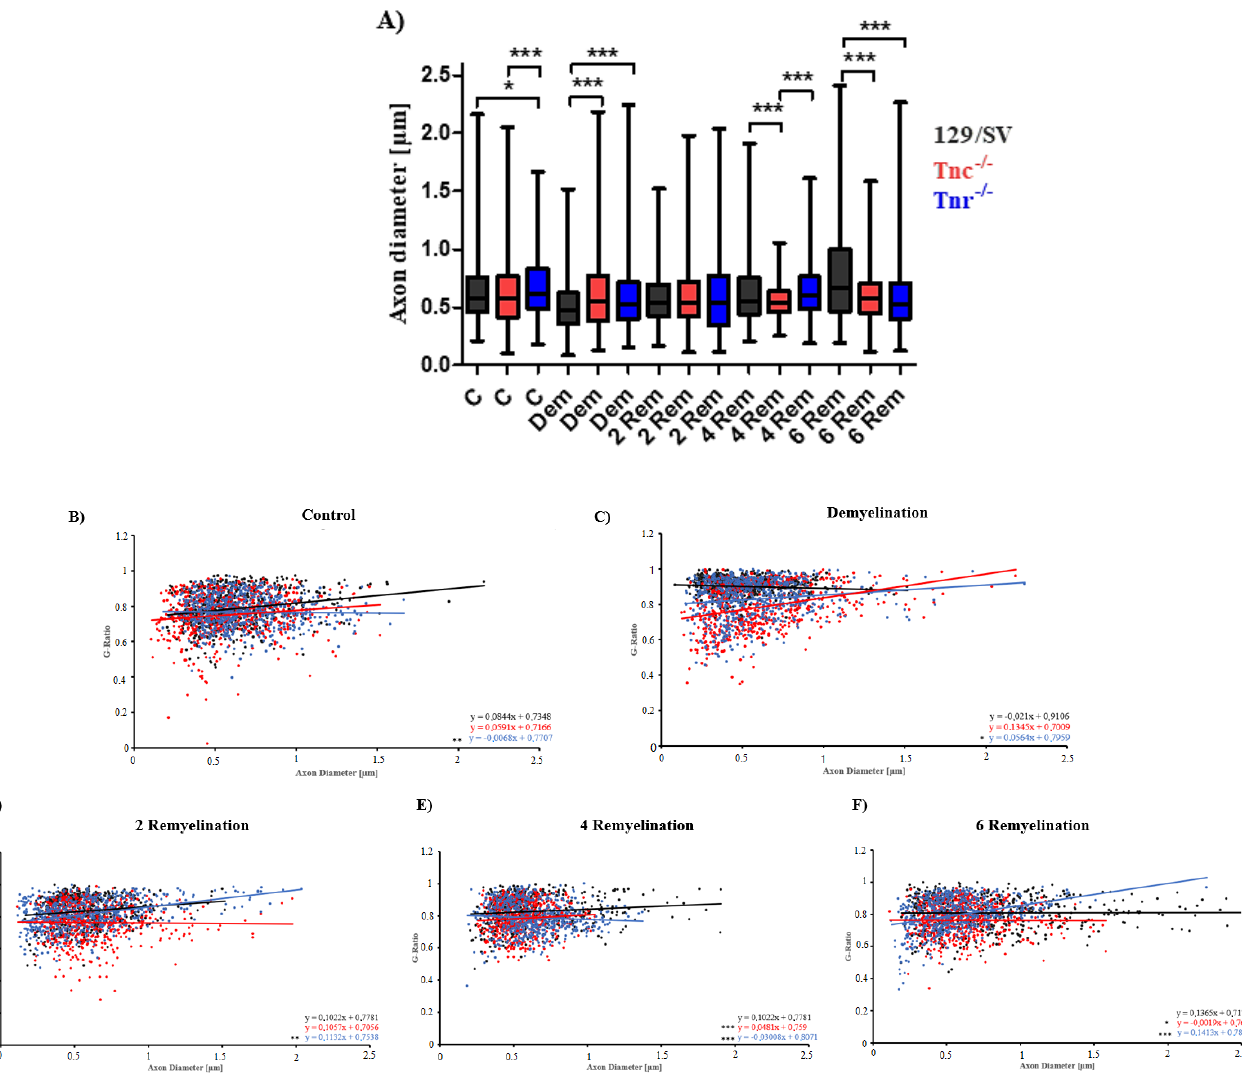
Figure 4. Axon diameter variability of the three genotypes does not seem to have a big influence on the myelination processes. Axon diameter of 129/SV, Tnc − / − and Tnr − / − electron microscopy sections of the five different conditions control (C), demyelination (DM), and 2-, 4- and 6 weeks of remyelination (RM2, RM4, and RM6) were analyzed ( A ). In the untreated control condition only in Tnr − / − mice the axon diameter of the cells was significantly larger than in wildtype mice. Interestingly, during demyelination the determined axon diameters of both Tnc − / − and Tnr − / − mice were significantly lower than in wildtype mice. ( B – F ) The best fit lines were also obtained by linear regression and differed significantly between Tnr − / − and wildtype mice in each treatment condition. Statistical analysis was carried out by using the ANOVA and Tukey ’ s multiple comparison test ( p ≤ 0.05 *, p ≤ 0.01 **, p ≤ 0.001 ***) . (N = 3, n ≤ 5 94).